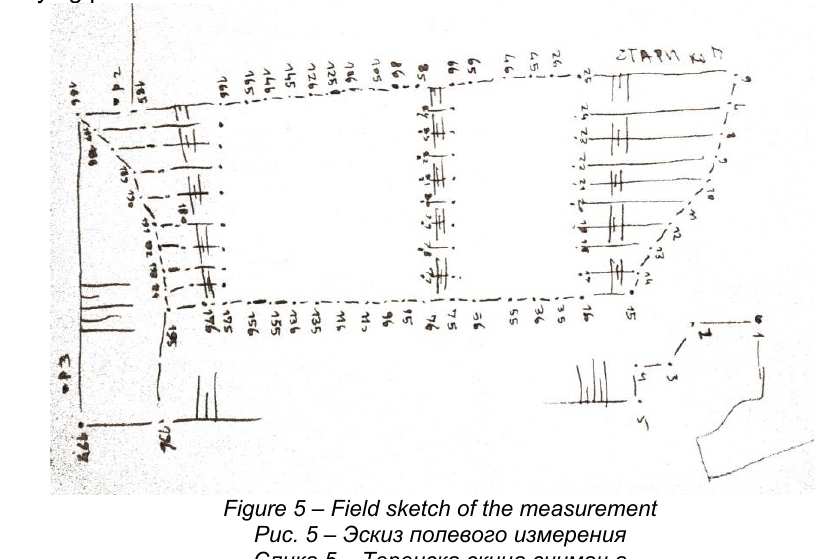
Figure 5 – Field sketch of the measurement Рис . 5 – Эскиз полевого измерения Слика 5 – Теренска скица